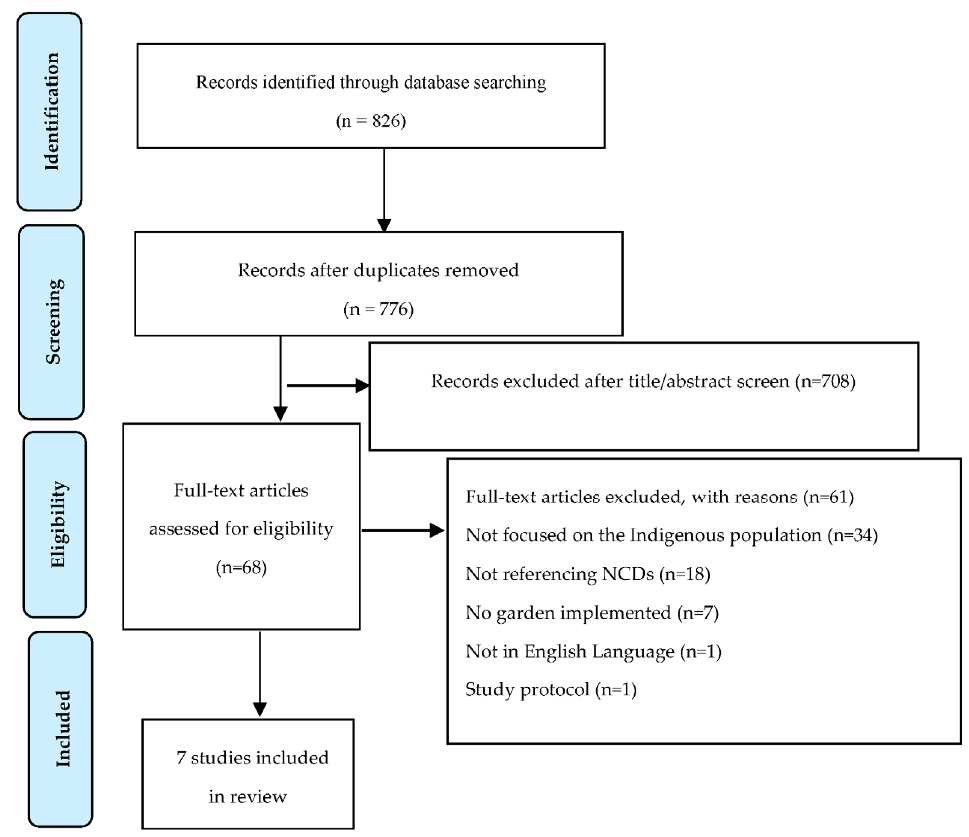
Figure 1. PRISMA diagram: (adapted from Moher et al. [43].